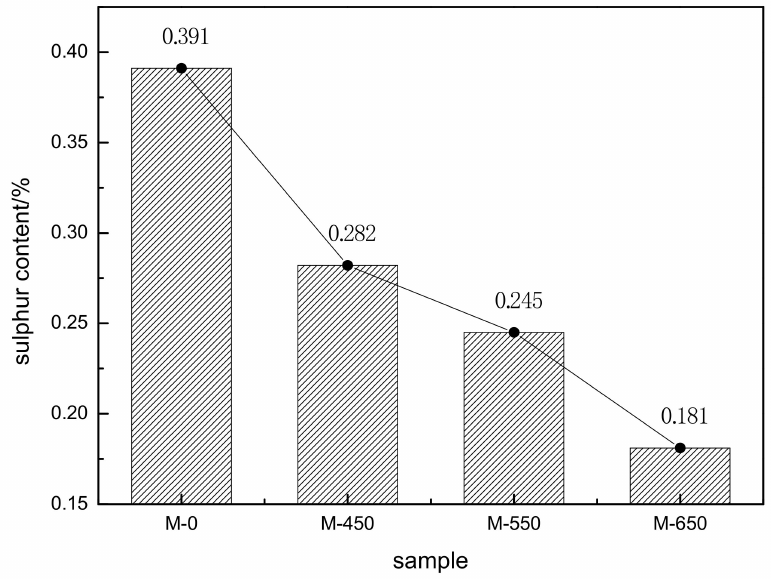
Figure 2. Sulfur content of the different samples.